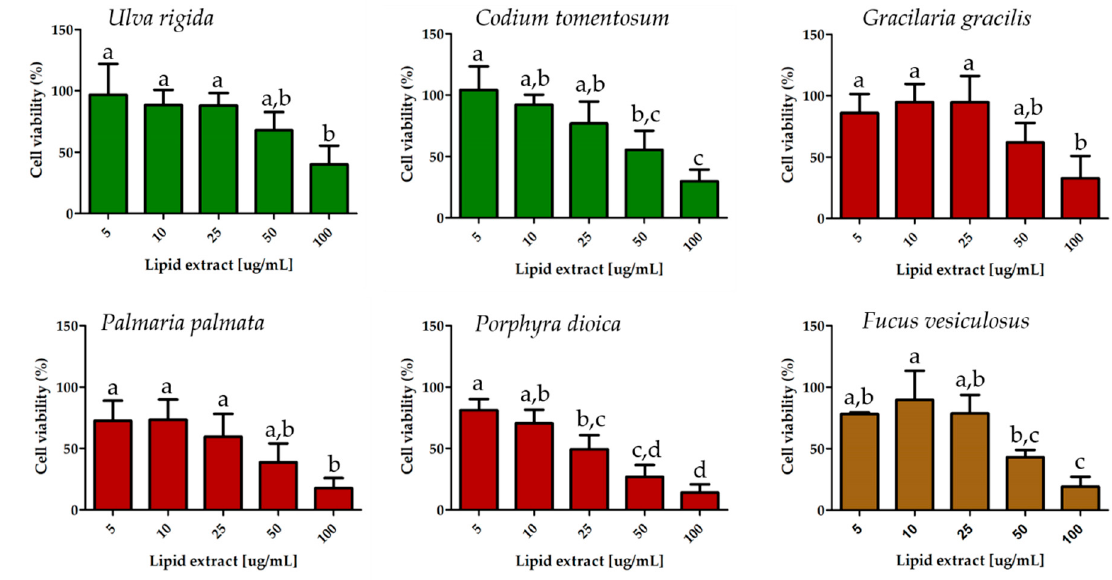
Figure 2. Antiproliferative e ff ect in MDA-MB-231 cell viability of the lipid extracts of Ulva rigida , Codium tomentosum , Gracilaria gracilis , Palmaria palmata , Porphyra dioica and Fucus vesiculosus at five distinct concentrations. Control values obtained for cell culture without lipid extract correspond to cell viability of 100% and are not represented in the bar graphs. Values are presented as the average of three assays ( n = 3) ± standard deviation (Tukey’s HSD post hoc analysis, p < 0.05). Di ff erent letters in the same graph represent significant di ff erences among concentrations.